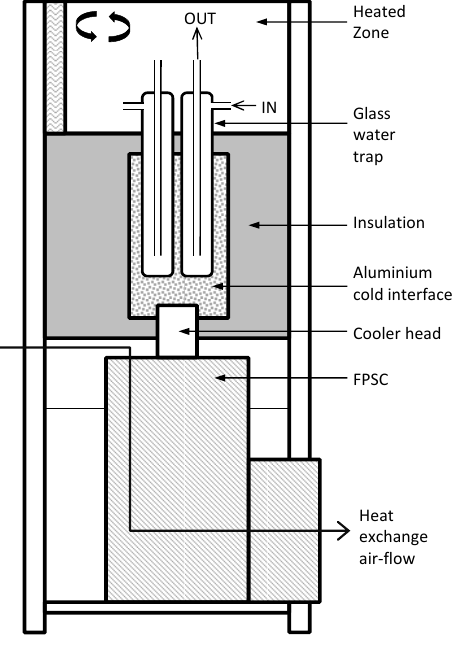
Figure 4. Schematic of the free piston Stirling cooler (FPSC) water Figure 4. Schematic of the Free Piston Stirling Cooler (FPSC) wa- trap. Glass water traps are cooled to − 30 ◦ C via a billet aluminium ter trap. Glass water traps cooled to -30 ◦ C via a billet aluminium interface insulated using milled expanded polyurethane foam. interface insulated using milled expanded polyurethane foam. Figure 5. Purge efficiencies for 20 mL (top) and 84 mL (bottom) Figure 4. Schematic of the Free Piston Stirling Cooler (FPSC) wa- ter trap. Glass water traps cooled to -30 ◦ C via a billet aluminium interface insulated using milled expanded polyurethane foam. Figure 5. Purge efficiencies for 20 mL (top) and 84 mL (bottom)